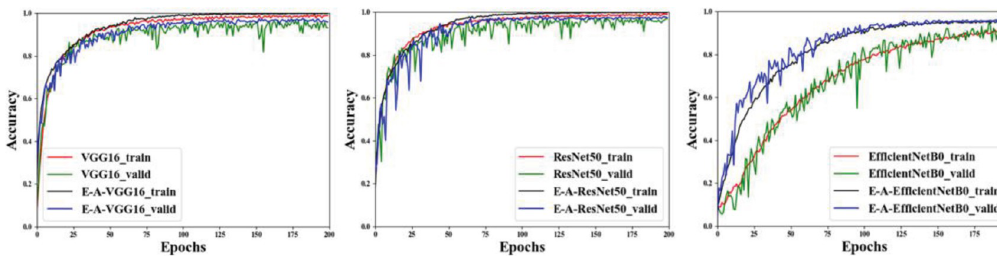
Fig 9. Training validation curve.